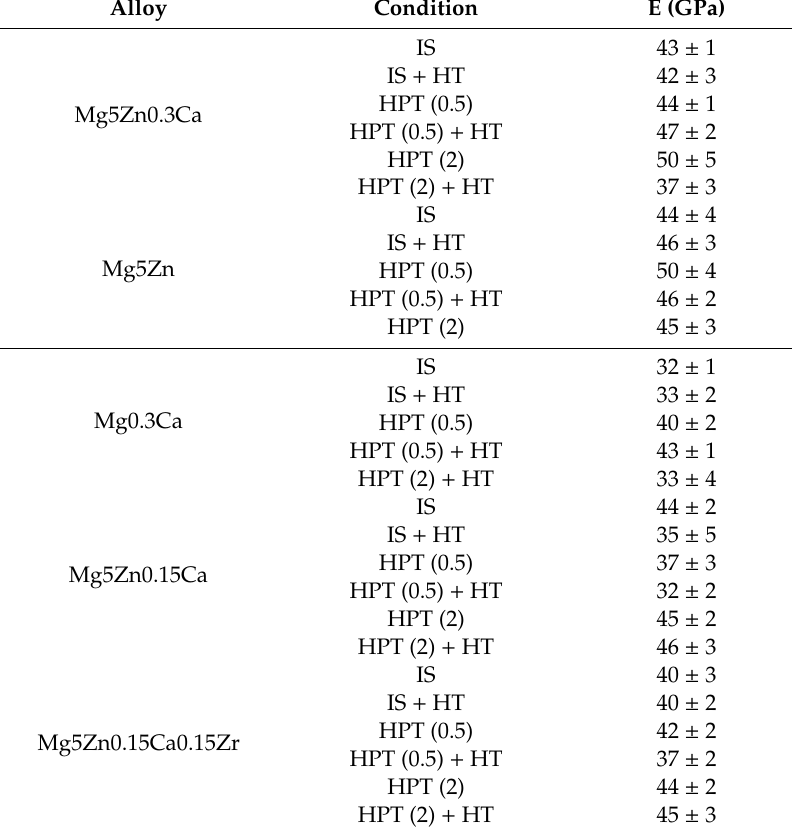
Table 5. Young’s moduli of all alloys in various